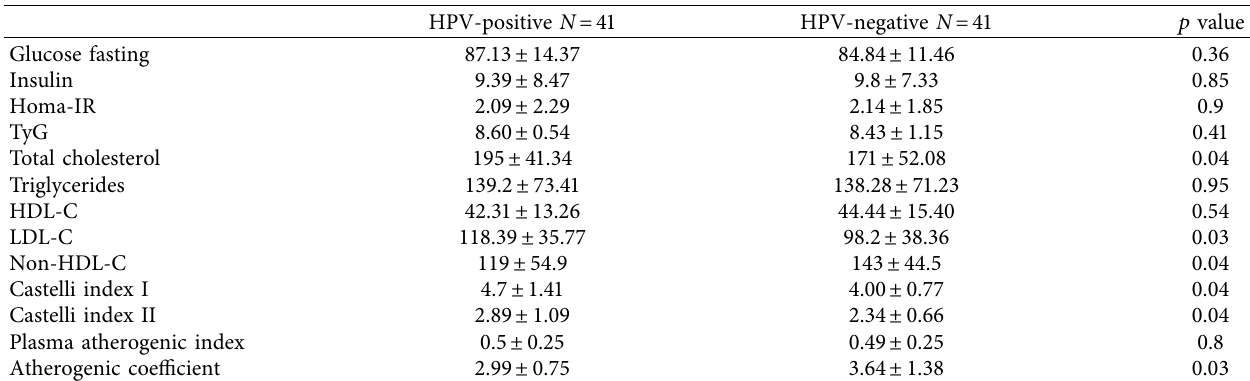
Table 3: Laboratory results of HIV-positive women with and without HPV coinfection, São Lu´ıs, Maranhão, Brazil,